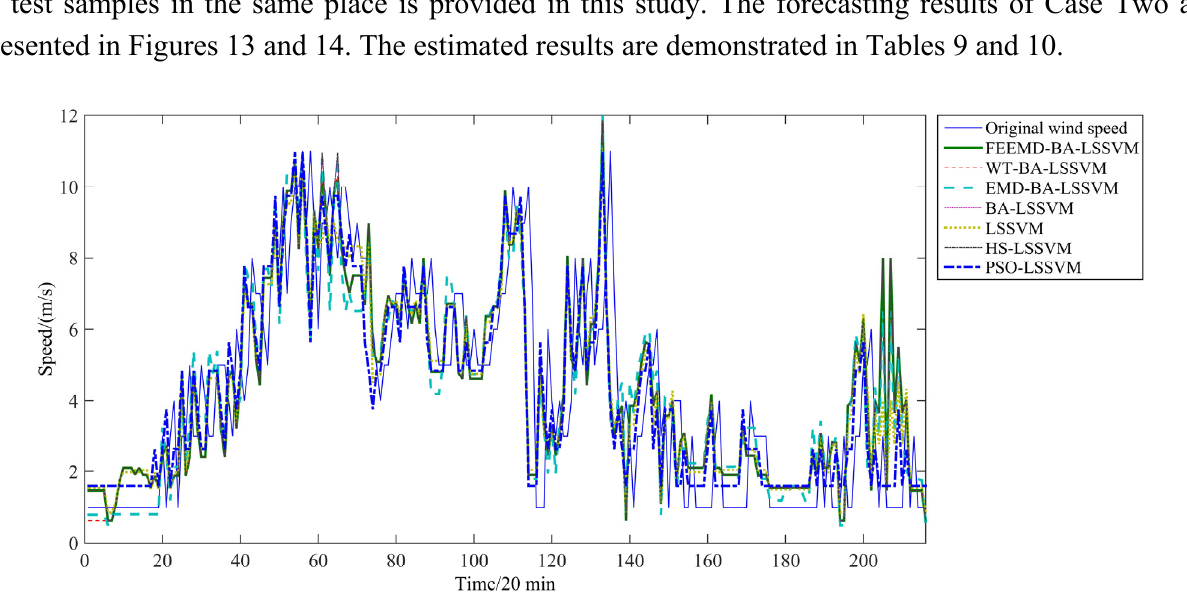
Figure 13. Forecasting results with temperature as argument.